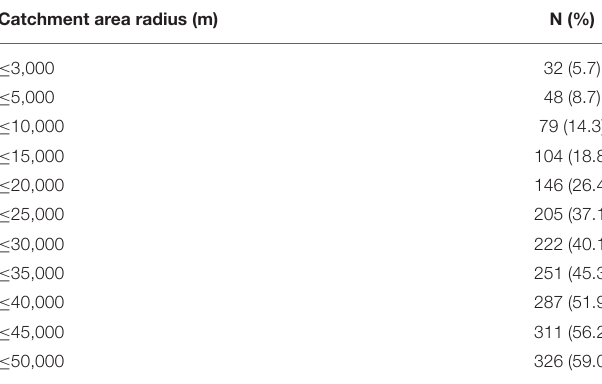
TABLE 7 | Distribution of first ANC visit by catchment area